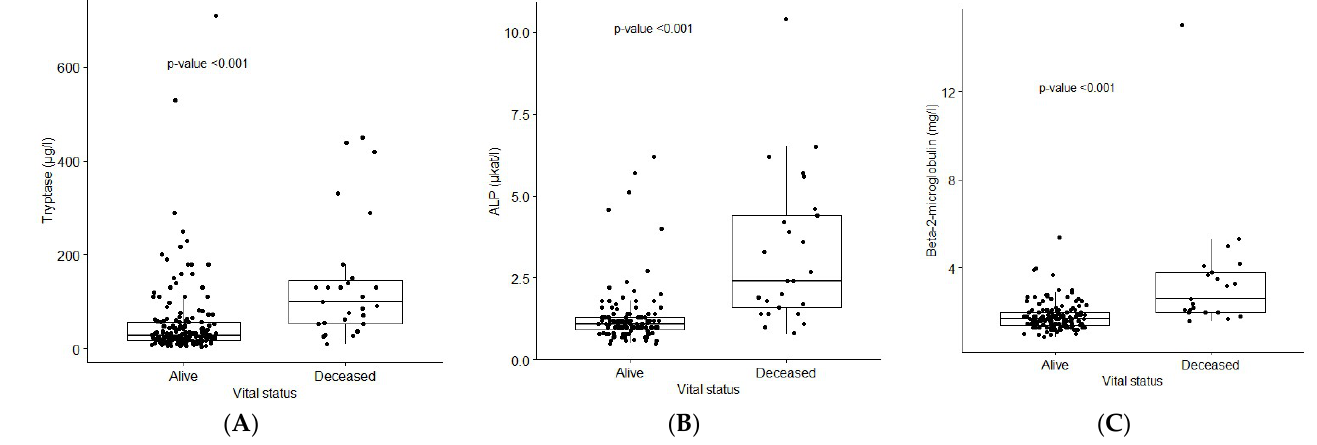
Figure 4. Associations between vital status and tryptase, ALP, and B2M levels: Boxplots were created to study relationships between vital status and ( A ) tryptase, ( B ) ALP and ( C ) B2M levels; p -values were calculated using the Mann–Whitney U -test.